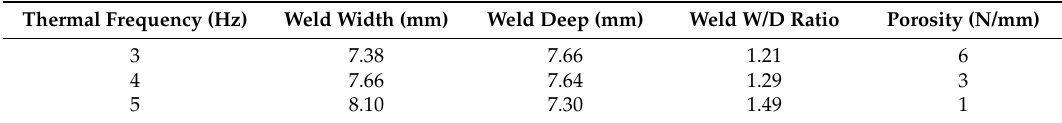
Table 3. Macrostructure details and porosity of weld beads.